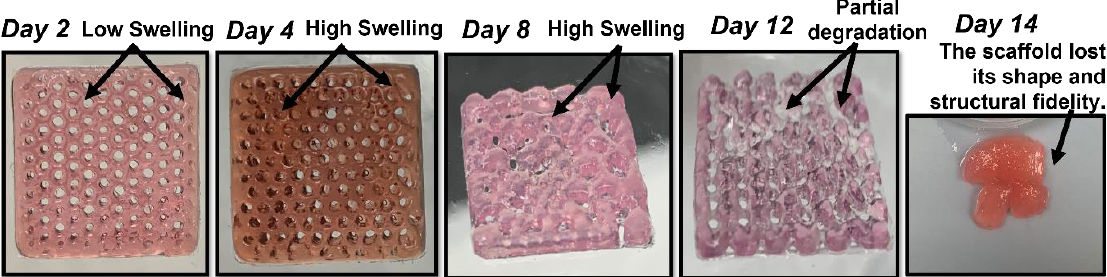
21 of 28 Figure 7. ( a ) Weight distribution of the alginate – gelatin scaffolds over the incubation period indi- cating the swelling nature of different printed scaffolds over time. ( b ) Swelling percentage of the printed scaffolds over 14 days. * indicates that at 0.05 level (two-way ANOVA), the variation in the crosslinking concentrations had a significant effect on the swelling percentage of the scaffolds. ^ indicates that at the 0.05 level (two-way ANOVA), varying alginate concentrations had a significant effect on the swelling percentage of the scaffolds. Interestingly, the A8-G6 scaffolds crosslinked with different CaCl 2 concentrations ex- hibited significant swelling over 14 days. The scaffolds swelling peaked on day 9 or 11. However, a slight decrease in weight could be observed after day 9 or 11, because of the degradation of the alginate and gelatin compounds due to excessive swelling. Addition- ally, the scaffolds lost their shape and structural fidelity at the end of the incubation period. The A12-G6 scaffolds exhibited a similar nature to the A8-G6 scaffolds, with a swelling percentage of 70% (Figure 7b). The digital images of the incubated scaffolds over time (Figure 8) gave a distinct interpretation of their swelling nature. They experienced a sharp